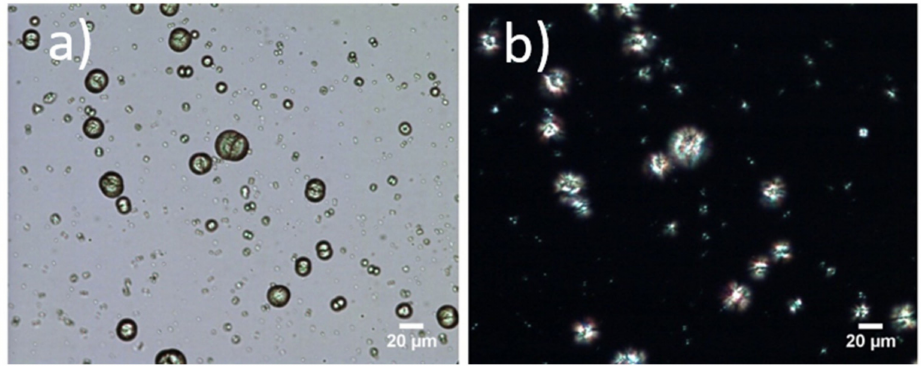
Figure 6. Microparticles formed from 10 mg · mL − 1 of P1 and 2 mg · mL − 1 of Dexa in distilled water examined by optical microscopy ( a ) with visible light, ( b ) with polarized light at room temperature.